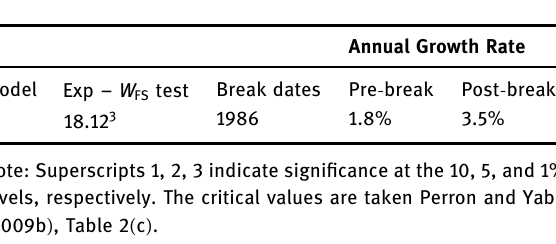
Table 1: Tests for structural changes in the level or slope of the trend function from Perron and Yabu ( 2009a,b ) : Australian real house prices, rhp t